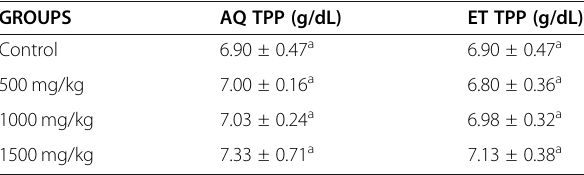
Table 3 Effect of aqueous and ethanolic extract of Spondias purpurea leaf on total plasma proteins in rats